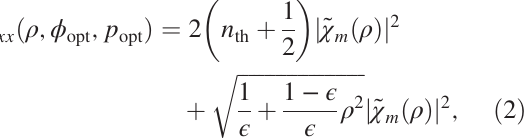
ffiffiffiffiffiffiffiffiffiffiffiffiffiffiffiffiffiffiffiffiffiffiffiffi 1